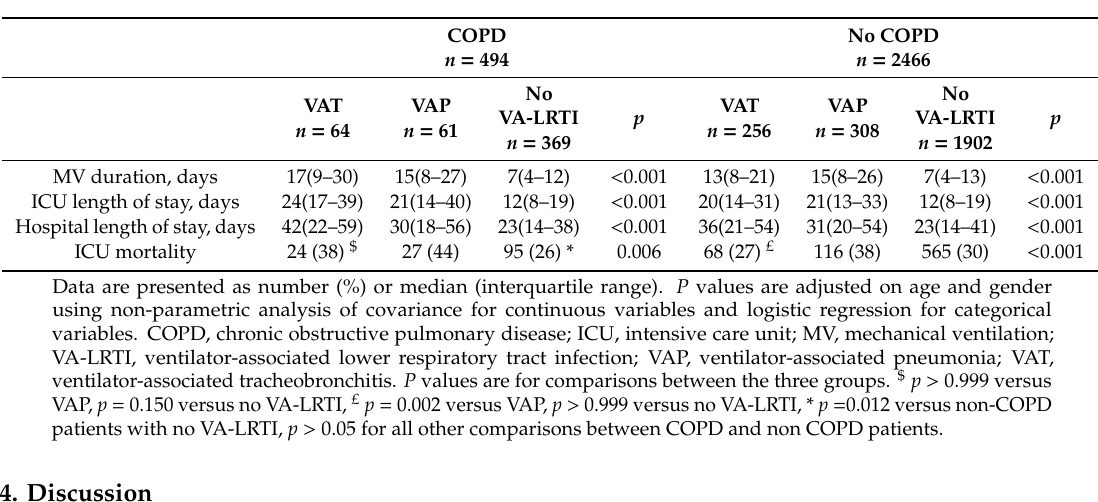
Table 5. Clinical outcomes of study